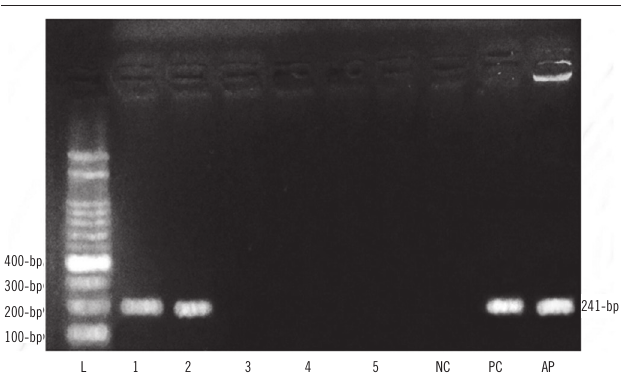
figure – Amplification of the 241-bp fragment of C. trachomatis DNA in 1.5% agarose